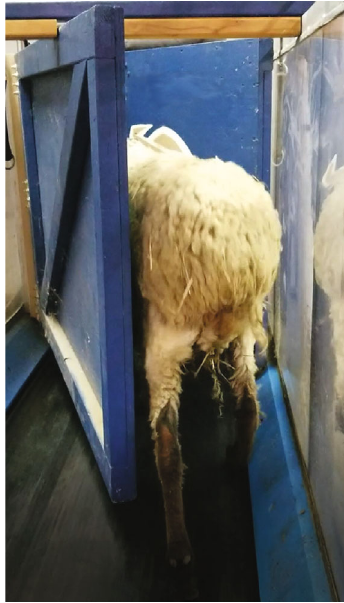
Figure 3: After CCLD, sheep were subjected to oblique angle forced exercise by treadmill for the exacerbation of osteoarthritis as part of a novel gene therapy